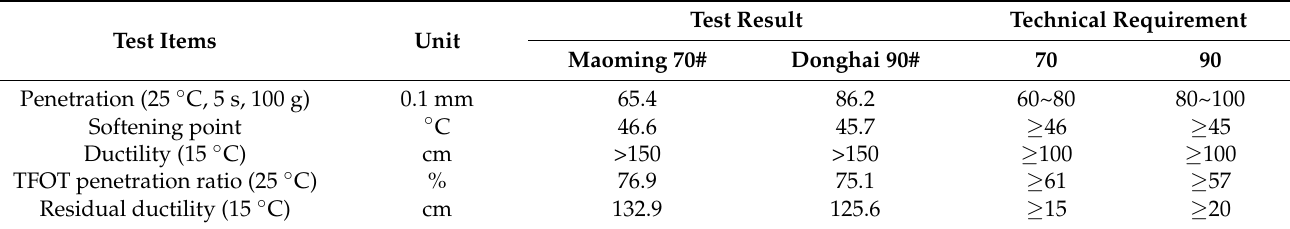
Table 2. Maoming 70# and Donghai 90# base asphalt performance indexes.